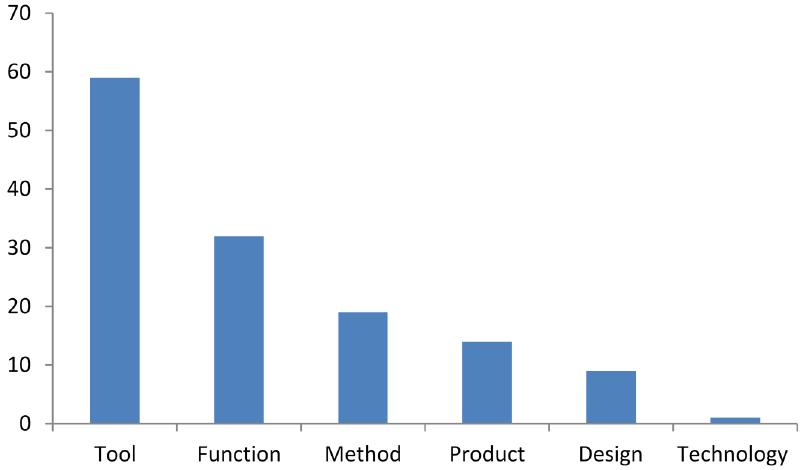
Figure 9. Innovation types that focused on either sustainability, safety or